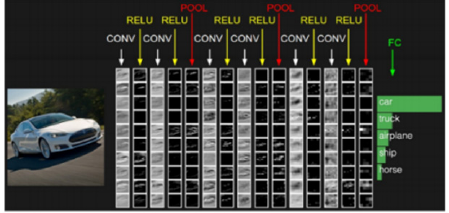
Figure 8. Convolutional Neural Networks layers (source [146]).